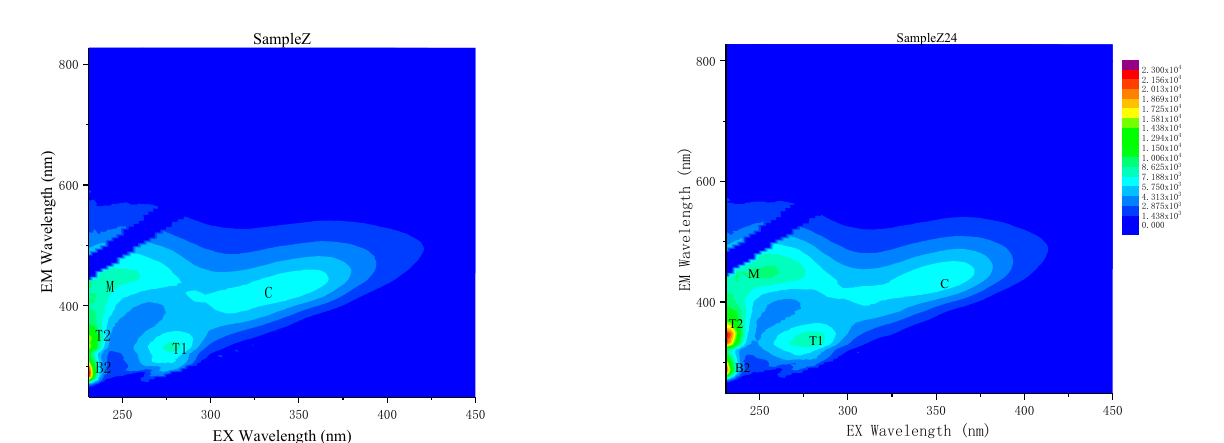
Figure 9. 3DEEM contour of a natural water Sample W, W 24 and samples added with different proportions of CBM produced water (the color bar represents the change of spectral intensity, where all eight figures are under the same color bar).